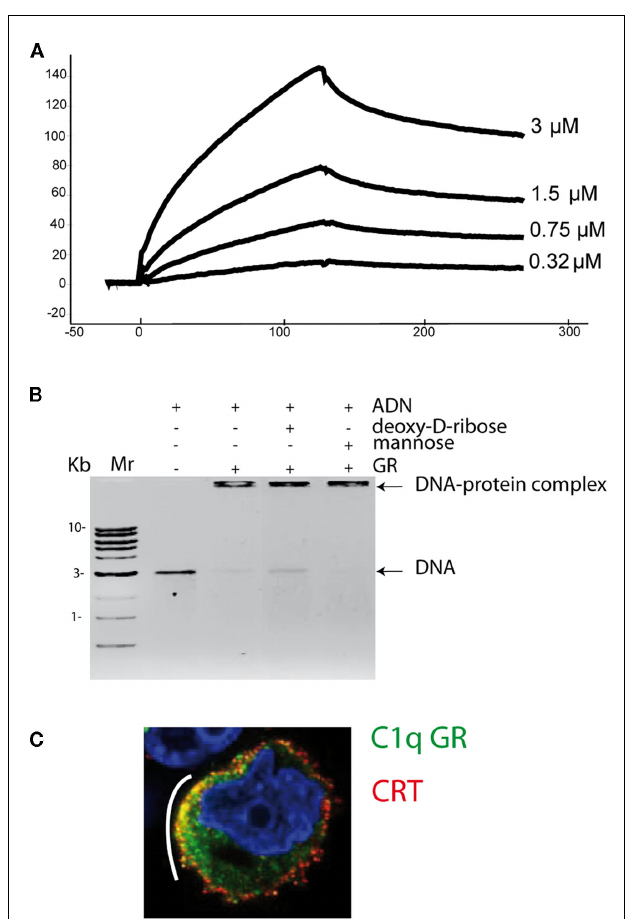
FIGURE 3 | C1q binding to apoptotic cell ligands. (A) Surface plasmon resonance analysis of the binding of the C1q globular domain to immobilized phosphatidylserine.The concentrations of the C1q globular domain are indicated. (B) Electrophoretic mobility shift assay showing that complex formation between DNA and the C1q globular domain is partly inhibited by 100mM deoxy-D-ribose. Mannose was used as a negative control. DNA molecular weight markers are shown on the left. (C) Early apoptotic HeLa cells were submitted to a double-immunofluorescence labeling for the C1q globular domain (C1q GR, green) and calreticulin (CRT, red) followed by confocal laser microscopy detection. Nuclei were labeled with Hoechst (blue).The white bow indicates areas where the C1q globular domain co-localizes with calreticulin. (From Païdassi et al., 2008a,b, 2011).